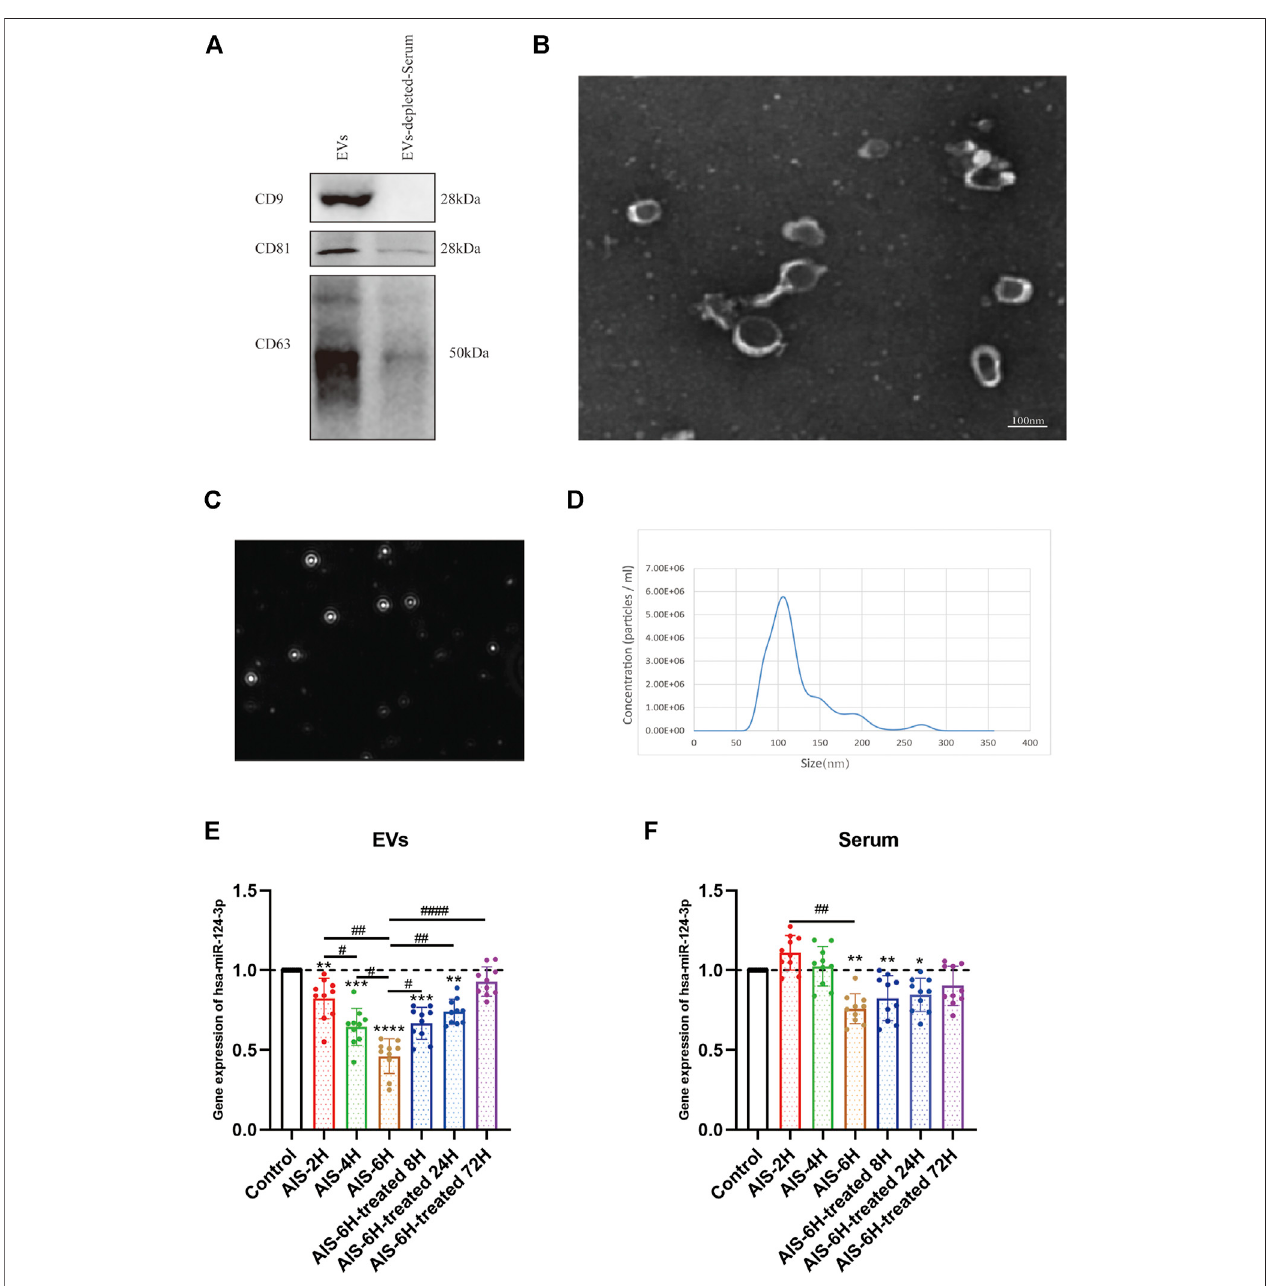
FIGURE 2 | Characterization of control EVs and gene analysis of hsa-124-3p in serum-derived EVs and serum. (A) Representative image of Western blotting showedbandsofstandardsurfacemarkers( CD9 , CD63 ,and CD81 )ofEVsandEV-depletedserum. (B) MorphologyofEVs wasmonitored byTEM;scalebar:100 nm. (C,D) Particle size distribution of EVs was determined by NTA. (E,F) Gene expression of hsa-miR-124-3p in EVs and serum of different samples at different time points. Compared to the control group: * p < 0.05; ** p < 0.01; *** p < 0.001; **** p < 0.0001, # Difference between groups: # p < 0.05; ## p < 0.01; #### p < 0.0001; one-way ANOVA with the Newman – Keuls multiple comparison